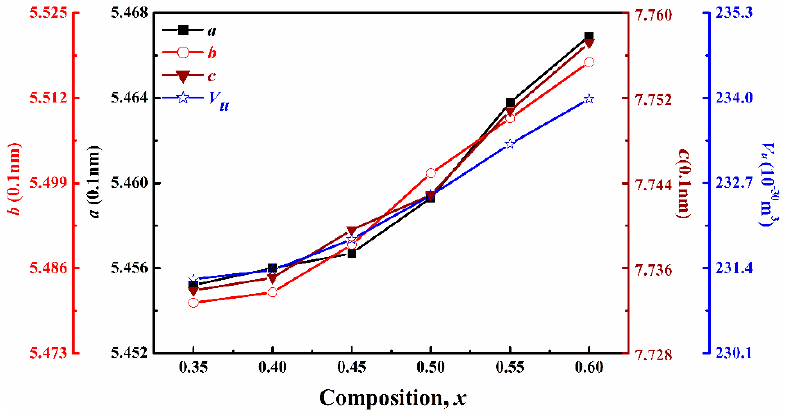
Figure 4. Lattice constant and unit cell volume of the (1– x )CLT − x NMT ceramics.